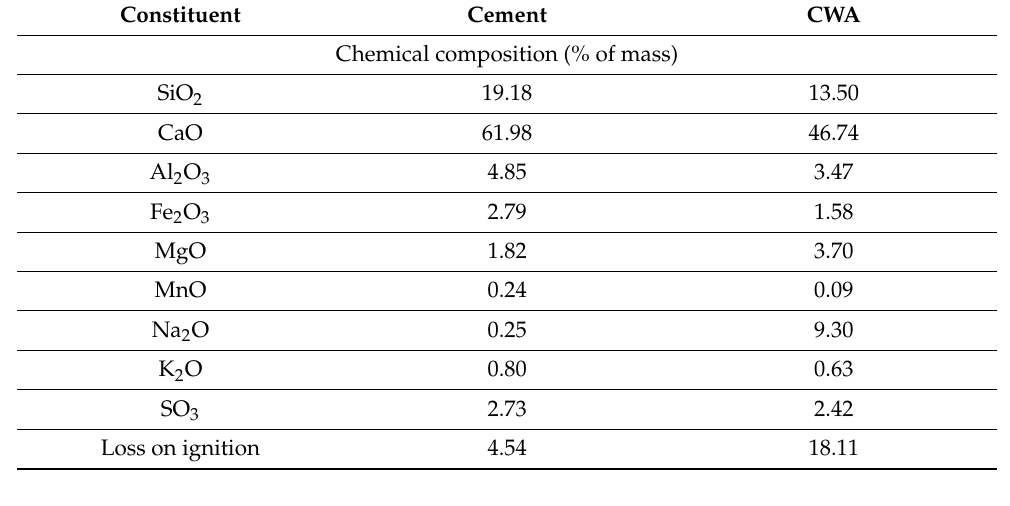
Table 1. Chemical composition of cement and crystalline waterproofing admixture (CWA).